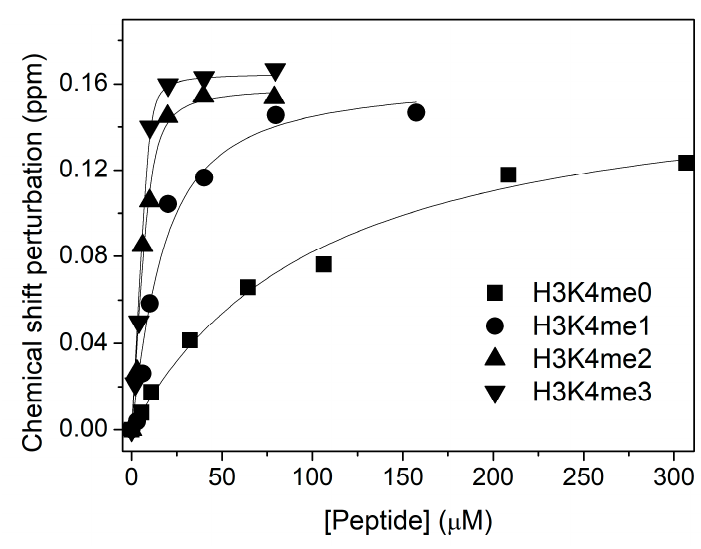
Figure 4. NMR analysis of the binding of ING4 PHD to H3K4me0/1/2/3 peptides in presence of 15% Ficoll 70. The CSP of W237 amide resonance of the PHD in 1 H- 15 N-HSQC spectra is represented as a function of peptide concentration for each titration. The continuous lines are the fittings to the binding model, and the height of the symbols corresponds with the experimental error. The measured K D values are 100 ± 10, 12 ± 4, 1.4 ± 0.6, and 0.4 ± 0.3 µM, respectively.